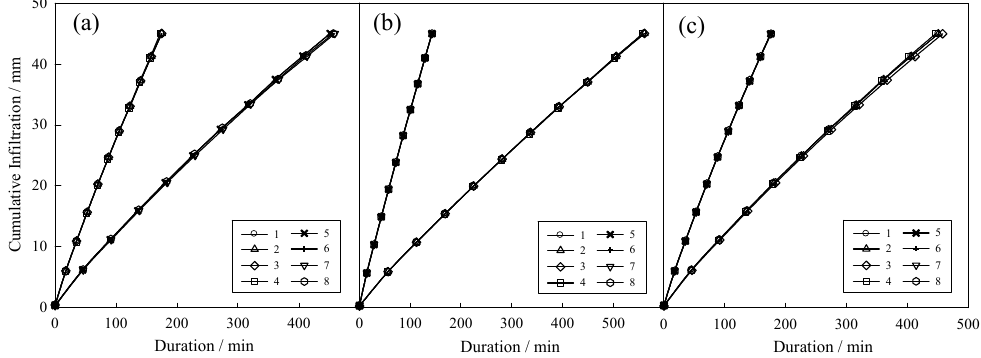
Figure 8. Effect of layered soil depth on film hole infiltration. ( a ) Experimental soils: 1–4 sandy loam ( γ d = 1.35 g · cm − 3 ) + silt loam ( γ d = 1.30 g · cm − 3 ); 5–8 silt loam ( γ d = 1.40 g · cm − 3 ) + sandy loam ( γ d = 1.45 g · cm − 3 ); ( b ) The soils selected from RETC software: 1–4 loamy sand + loam, 5–8 loam + loamy sand; ( c ) Double bulk densities: 1–4 silt loam, 1.40 g · cm − 3 + 1.30 g · cm − 3 ; 5–8 sandy loam, 1.35 g · cm − 3 + 1.45 g · cm − 3 . For Nos. 1–8: 1 and 5—upper depth 15 cm; 2 and 6—upper depth 20